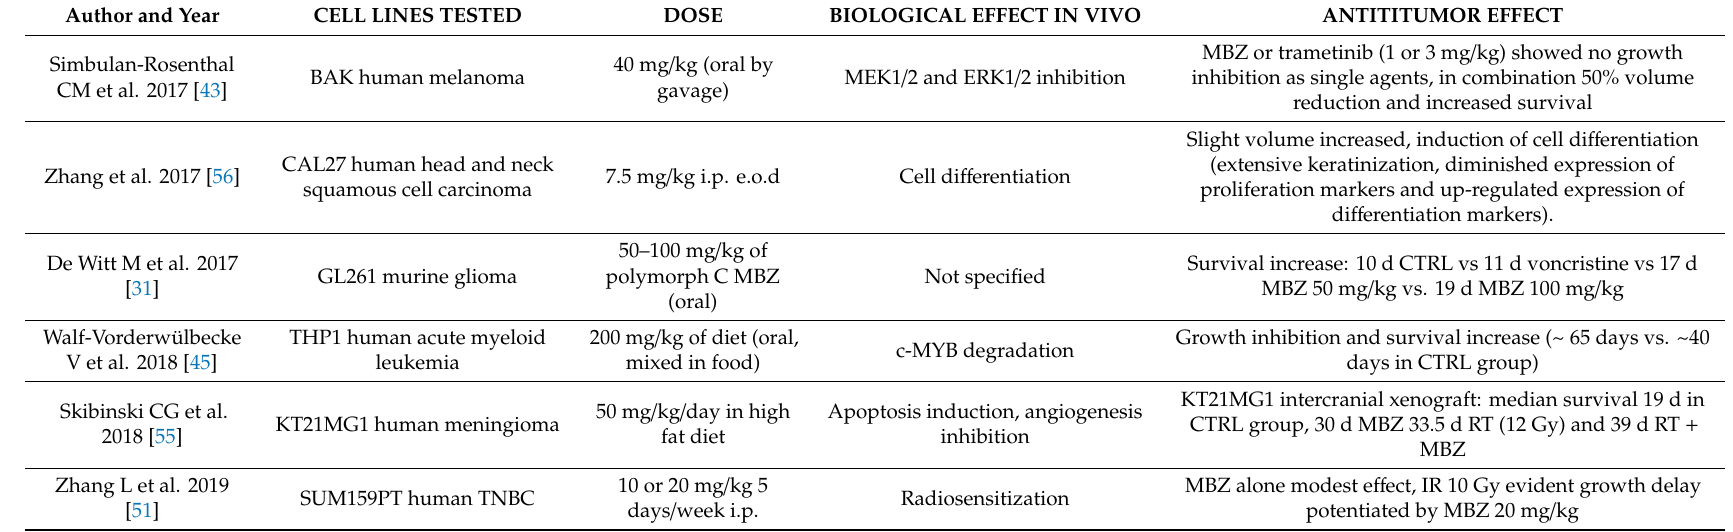
Table 4. Studies reporting MBZ anticancer activity in vivo and its mechanisms of action. Abbreviations: e.o.d = every other day; I.p. =